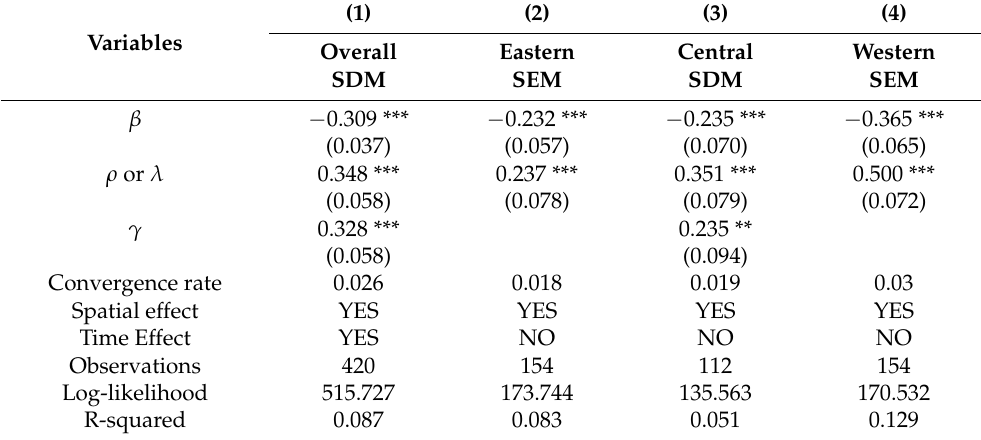
Table 6. Absolute β convergence of the livelihood resilience of rural residents in China by